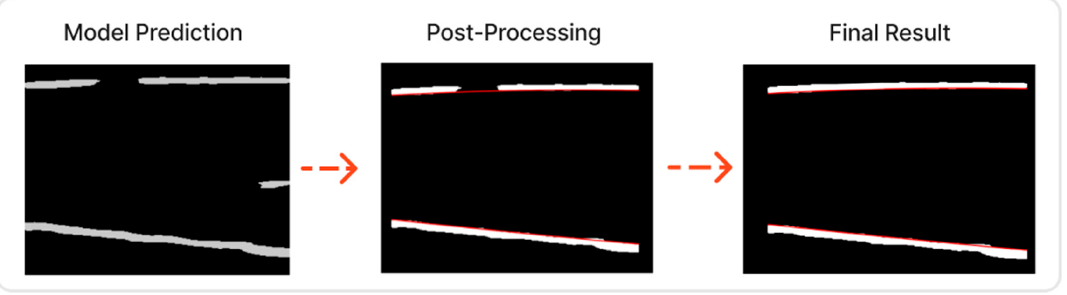
Figure 3. In the case that the predicted mask is not optimal, the post-processing improved the re- sult.